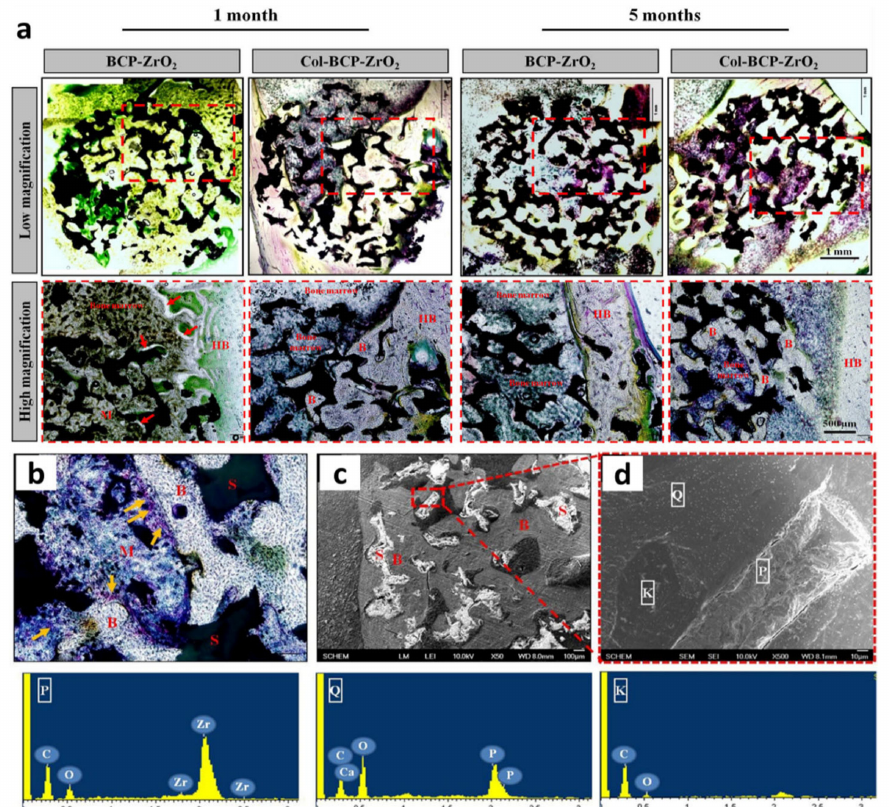
Figure 2. ( a ) Histological analysis of BCP/zirconia and Col-BCP/zirconia scaffolds 1 and 5 months after implantation in the femurs of rabbits, observed via Villanueva bone stains at low and high magnifications. HB: host bone; M: bone marrow; B: new-bone formation. ( b – d ) Histological analysis of Col-BCP-zirconia scaffolds after 5 months of implantation in the femurs of rabbits, observed via different methods. ( b ) Villanueva bone stain: HB, host bone; M, bone marrow; B, new-bone formation; S, scaffold. The SEM image in ( c ) is magnified in ( d ). The energy-dispersive X-ray spectroscopy profiles of P, Q and K were taken from ( c ). Images used from Lee et al. [52] reprinted with permission from Elsevier, copyright©